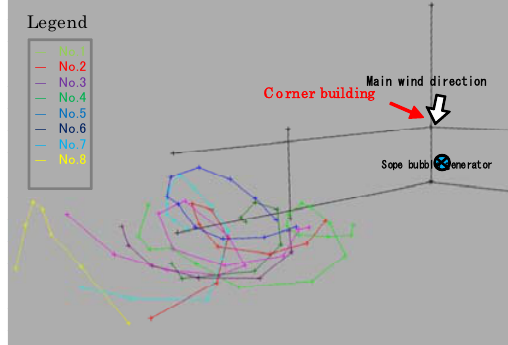
Figure 11. Outer view of building where the observation was carried out